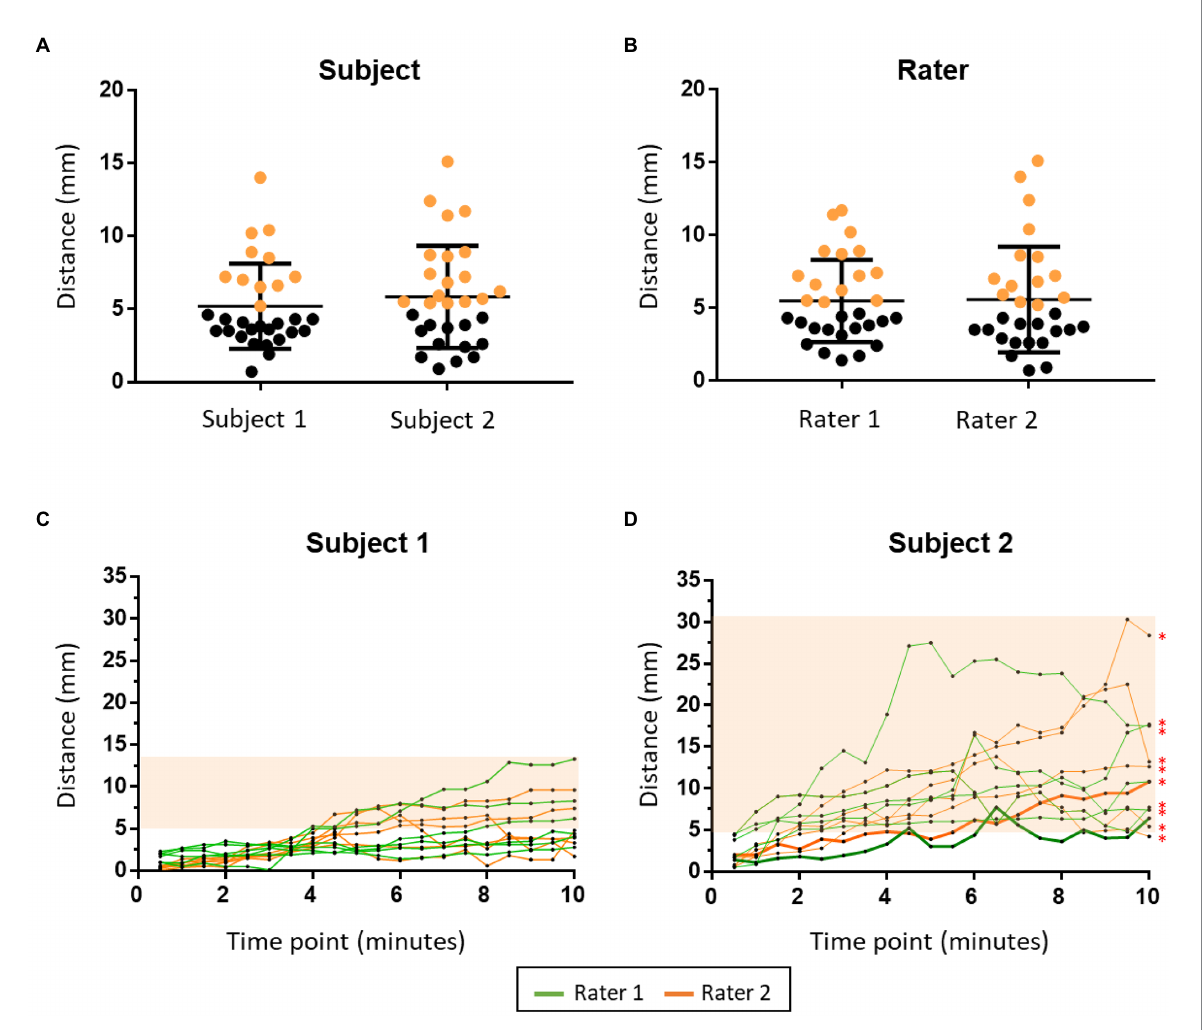
FIGURE 4 The findings of the coil misplacement experiment. The two figures in the upper panel show initial coil misplacement between subjects (A) and raters (B) . The misplacements greater than 5 mm are marked in orange. The two figures in the lower panel show the dynamic coil misplacement during the TMS session in subject 1 (C) and subject 2 (D) . The orange area shows the time points that have a dynamic coil misplacement larger than 5 mm. Thick lines in (D) show the rTMS session in which the mean dynamic coil misplacement was not significantly larger than 5 mm. *: TMS session that has a mean dynamic coil misplacement significantly larger than 5